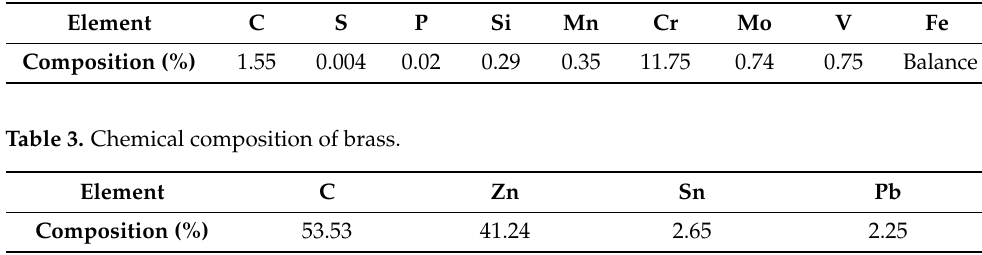
Table 2. Chemical composition of D2 steel.